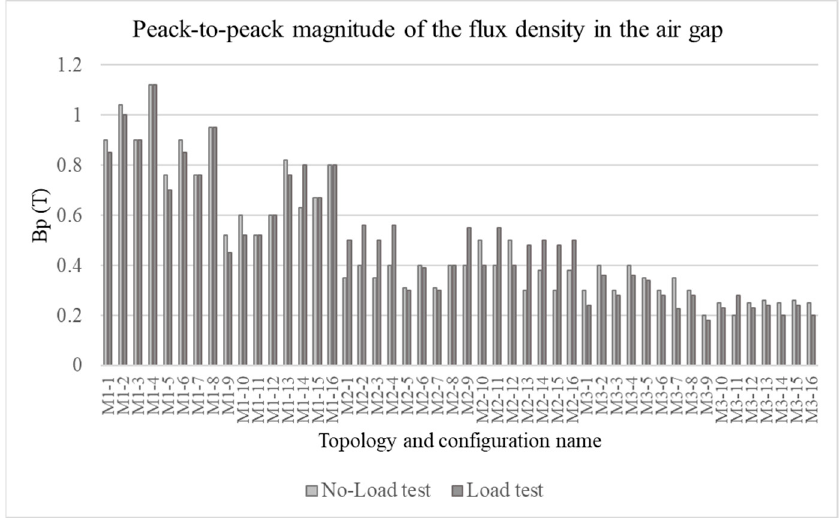
Figure 8. The flux density in air-gap for no-load and load tests of different configurations.